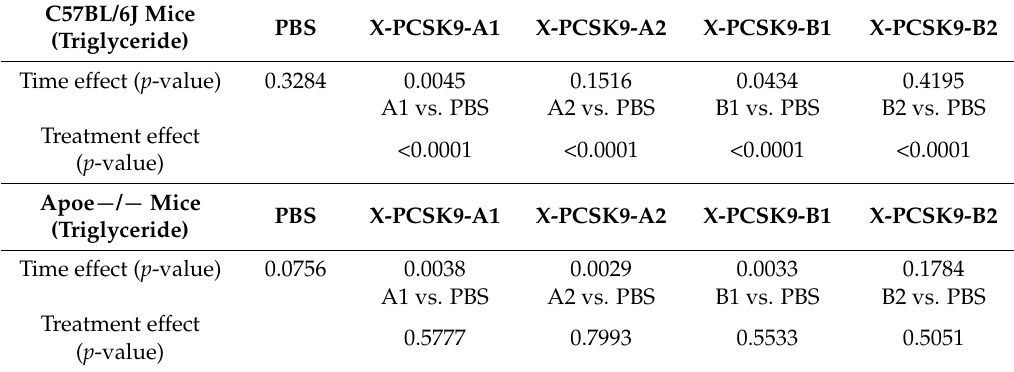
Table 5. Statistical analyses of the time and treatment effects of X-PCSK9 isomers, A1, A2, B1 and B2, on plasma triglyceride levels in C57BL/6J and Apoe − / − mice. The statistical analyses of all samples were performed using a linear mixed model including both fixed effects and random effects. The p -values of time effects on each treatment group are listed here. The p < 0.05 is considered